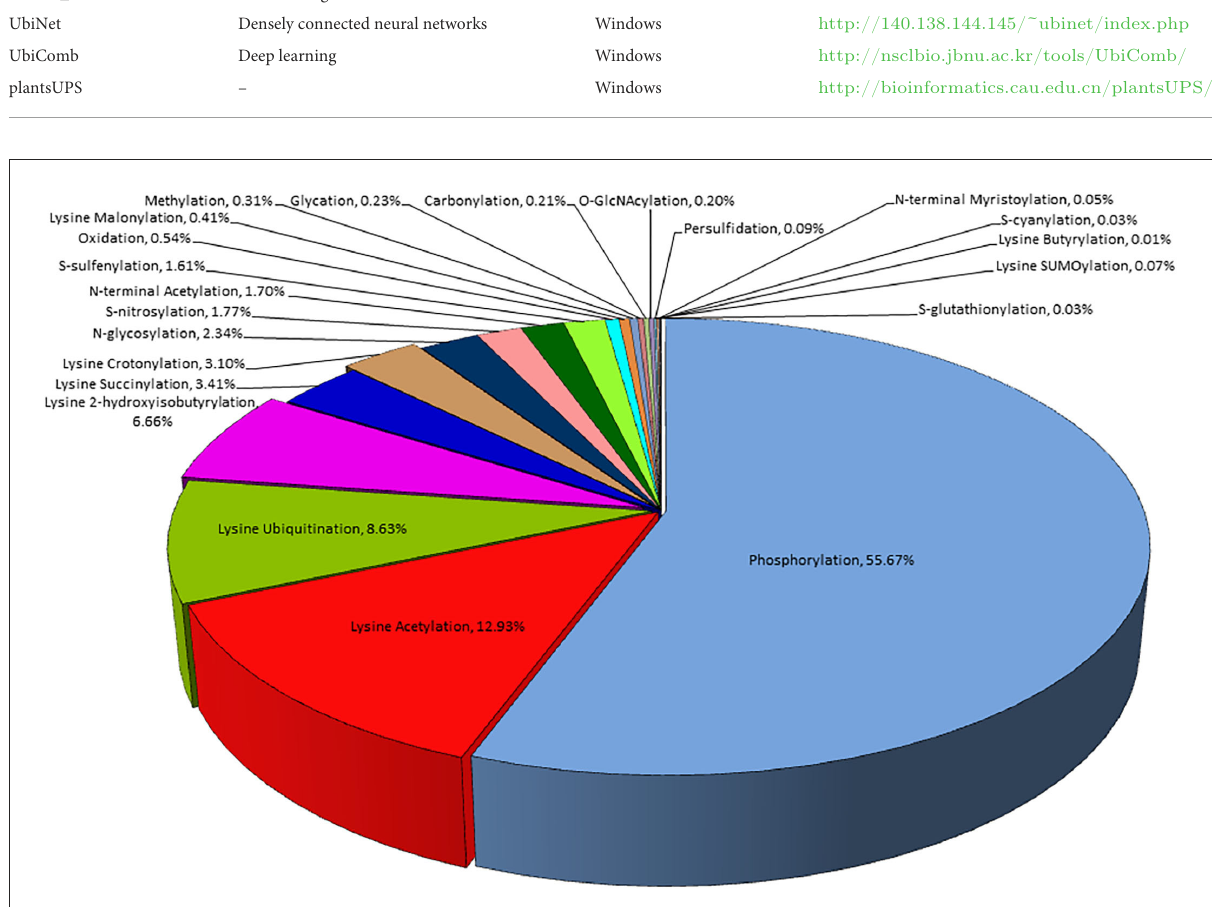
FIGURE2 Frequency of common PTM types in